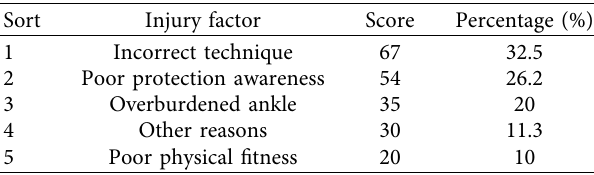
Figure 7: 6 injury types of sports professional athletes in colleges and universities. Table 5: Injury factors of sports